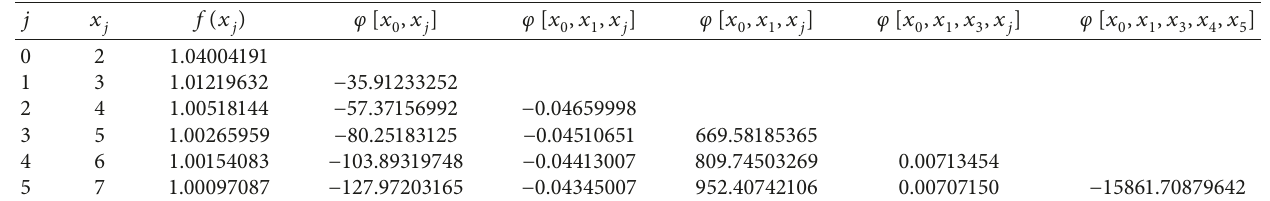
Table 3: Table of inverse